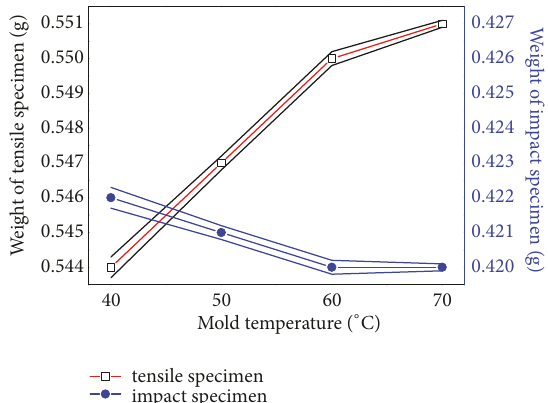
Figure 5: Influence of mold temperature on product